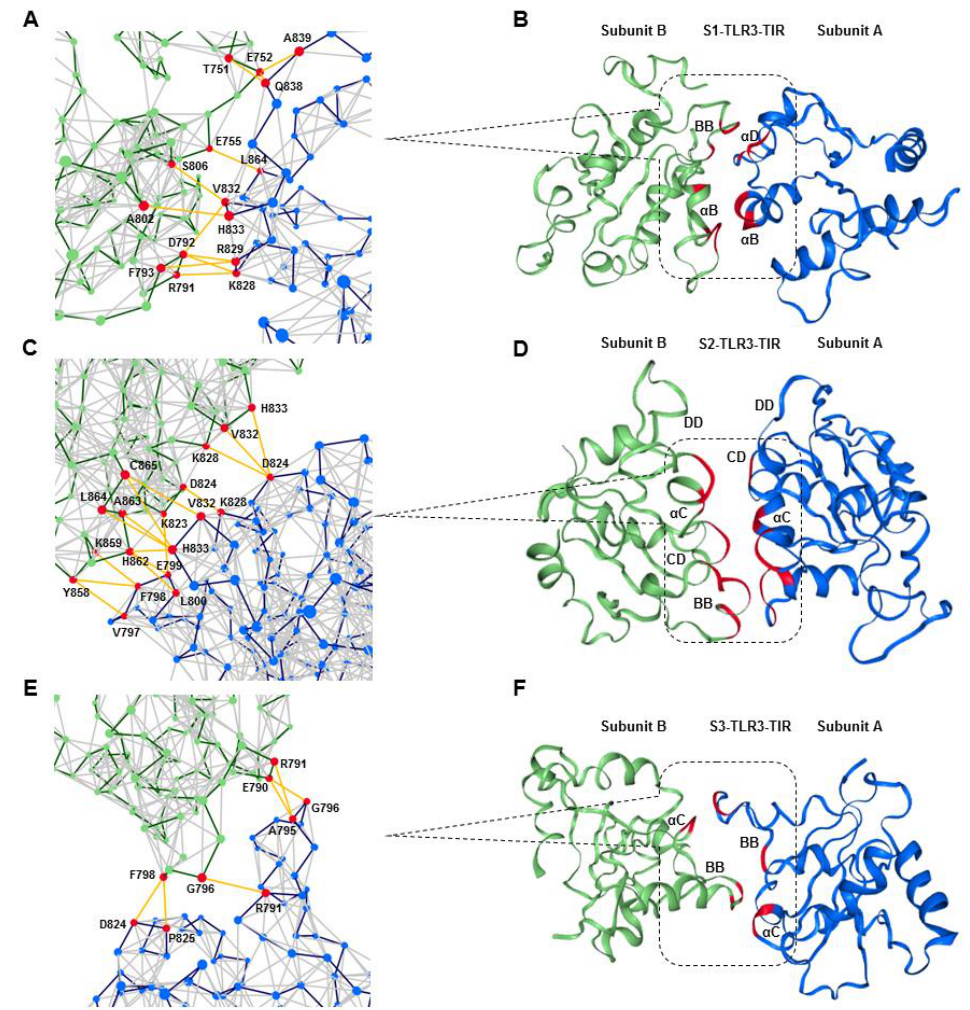
Figure 8. Packing interaction of the TIR domains. ( A , C , E ) A network view of representative TIR domains extracted from the low-energy ensemble of the molecular dynamics trajectories. Subunits A and B are colored in blue and green, respectively. Each node (represented as a dark circle) of the network represents a C α atom. The dark-blue or dark-green edges represent backbone contact, while the light-grey edges indicate nonbonded interactions. The orange lines represent inter-residue communication between nodes within a 7 Å distance threshold. ( B , D , F ) The domain view of the TIR dimers in line with the protein structure network.